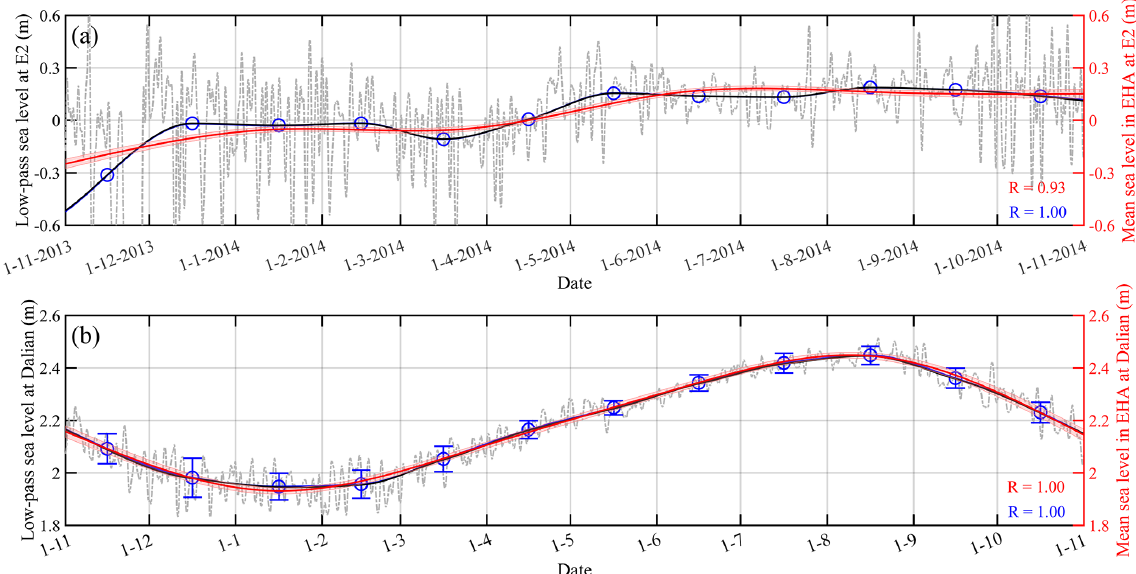
Figure 8. Time series of the original low-pass sea level (grey line), their monthly averages (blue circles), the interpolated values of the monthly averages using the cubic spline interpolation (blue line), and the estimated mean sea level using SHA (black line) and EHA (red line) at (a) E2 and (b) Dalian. Only the original low-pass sea levels with absolute values less than 0.6m are shown in panel (a) . Pink shading indicates the corresponding 95% confidence intervals, while blue vertical bars designate the standard deviation in multi-yearly